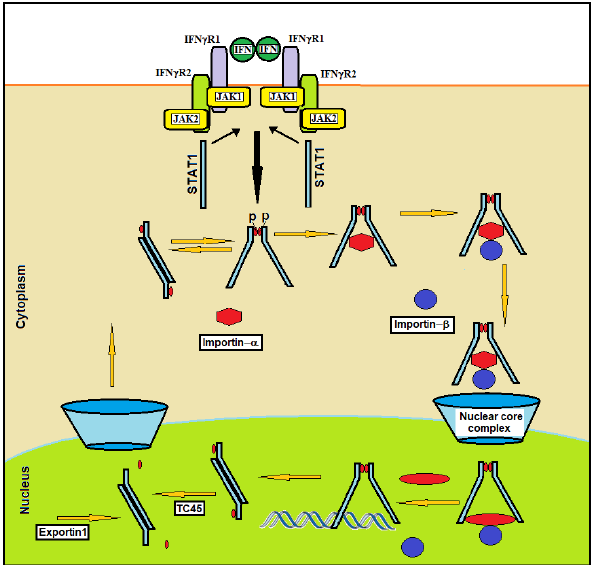
Figure 3. Model of STAT1 import and export after IFN γ stimulation. The binding of IFN to the cell surface receptor causes the recruitment and phosphorylation of STAT1. Through spontaneous dissociation and reassociation, the activated STAT1 molecules constantly oscillate between the parallel and antiparallel dimer conformations. The importin- α recognizes and binds to the NLS on the STAT1 dimer. After binding to the STAT1 dimer, importin- α binds to importin- β in the cytoplasm. This complex (STAT1/importin- α /importin- β ) interacts with the nuclear pore, and the movement that drives the import substrate complex into the nucleus appears to be generated between importin- β and structures of the nuclear pore. After interaction with the DNA and activation of transcription, STAT1 conformation shifts from parallel to antiparallel dimers, which is a conformation susceptible to dephosphorylation by the nuclear phosphatase TC45. Unphosphorylated STAT1 is then exported to the cytoplasm by exportin1.